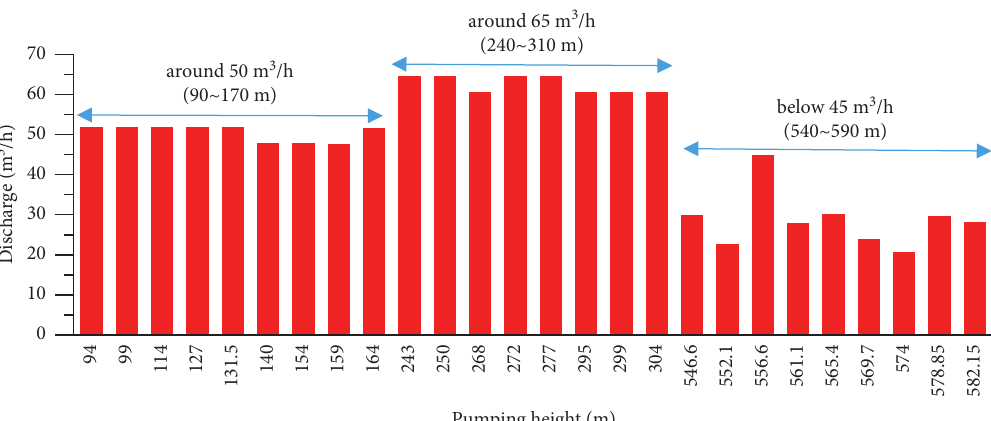
Figure 11: The pumping discharge for different pumping height